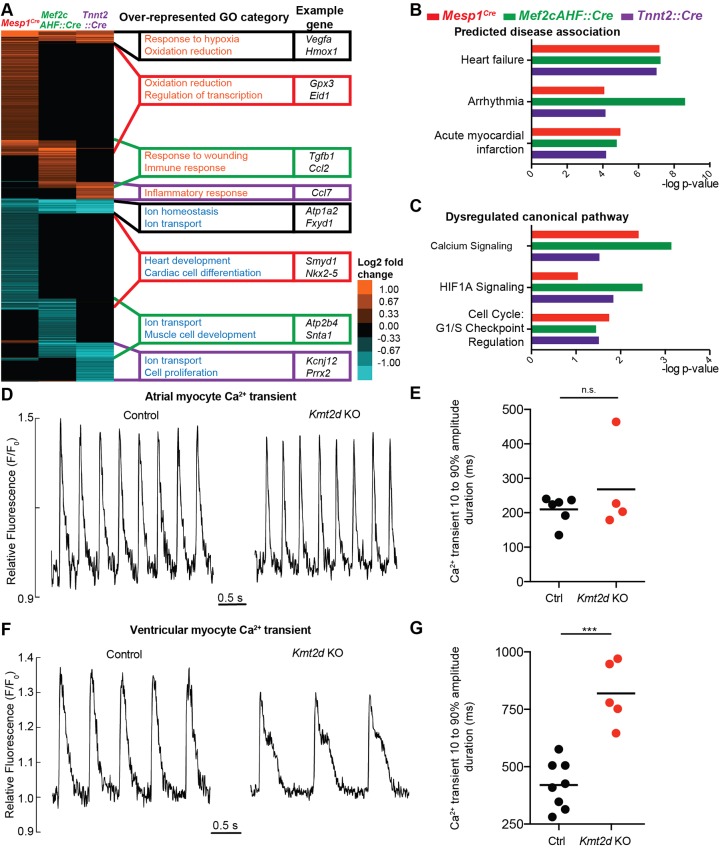
Deletion of Kmt2d in cardiac precursors and myocardium leads to downregulation of ion transport genes and altered calcium handling in ventricular cardiomyocytes. (A) RNA-Seq analysis comparing differentially expressed genes in E9.0 Mesp1Cre;Kmt2d fl/fl mutant hearts, E11.5 Mef2cAHF::Cre;Kmt2d fl/fl right ventricles and outflow tract and E11.5 Tnnt2::Cre;Kmt2d fl/fl mutant hearts (FDR<0.05). (B) IPA of differentially expressed genes in all three deletion genotypes shows that common disease associations that were significantly predicted are related to heart failure (P<0.05). (C) IPA shows that common canonical pathways that were significantly dysregulated are associated with calcium signaling, HIF1A signaling and G1/S cell cycle checkpoint regulation (P<0.05). (D) Representative Fluo-4 fluorescence recordings from control and Tnnt2::Cre;Kmt2d fl/fl (Kmt2d KO) atrial myocytes isolated at E11.5. (E) Mean durations of Ca2+-dependent Fluo-4 fluorescence transients plotted for control and Kmt2d KO atrial myocytes. Each point represents the Ca2+ transient duration from myocytes representing one embryonic heart, as determined at the level between 10% of the upstroke and 90% of the decay. An average of 5.8 samples (cells or clusters) were combined per point. n.s., no significant difference. (F) Representative Fluo-4 fluorescence recordings (upper panel) from control and Kmt2d KO ventricular myocytes isolated at E11.5. Typically, the Ca2+ transients, expressed relative to diastolic fluorescence (F0), showed similar peak amplitudes but strong differences in duration due to the presence of a late shoulder or plateau in the Kmt2d KO myocytes. (G) Mean durations of Ca2+-dependent Fluo-4 fluorescence transients plotted for control and Kmt2d KO ventricular myocytes. An average of 23 samples (cells or clusters) were combined per point. Kmt2d KO ventricular myocytes had a significantly prolonged duration at 819±137 ms (n=5) compared with controls at 420±103 ms (n=8) (***P<0.001).